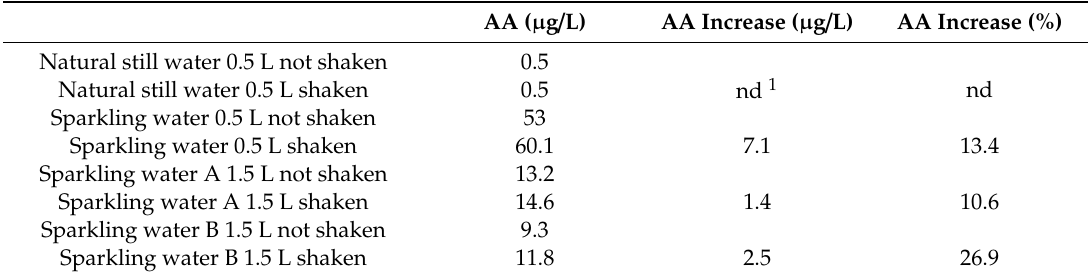
Table 3. Concentrations of acetaldehyde (AA) in samples subjected to shaking. A replicate of a 1.5 L sparkling water sample has been performed (A and B). 1 = not